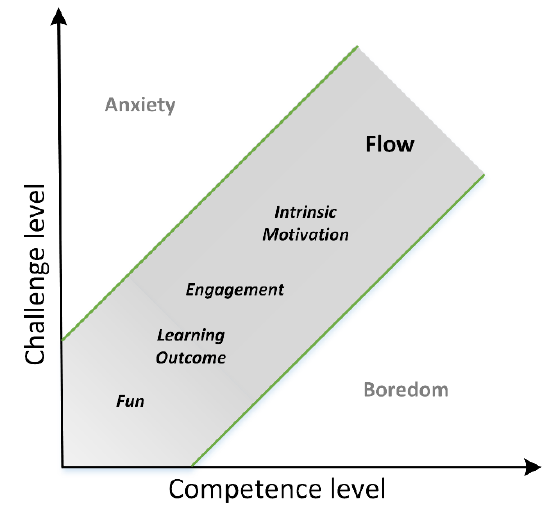
Fig. 3. Flow model (adapted from